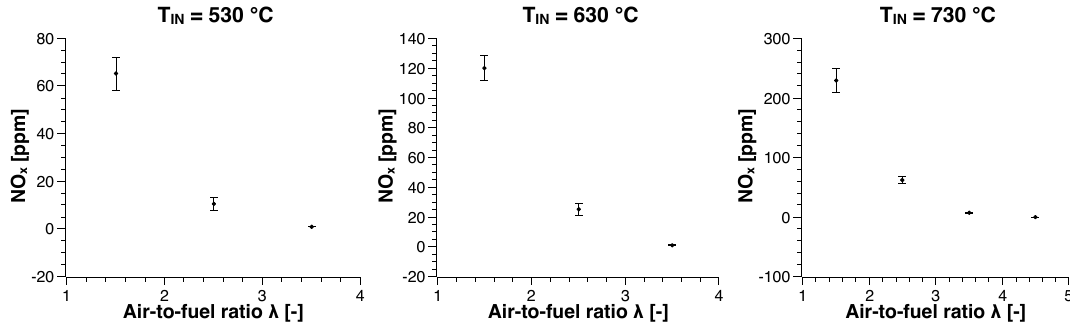
Figure 5. CO concentration (ppm) in the exhaust gases, normalized at 15% O 2 , as a function of the air-to-fuel ratio λ for different values of the air inlet temperature.